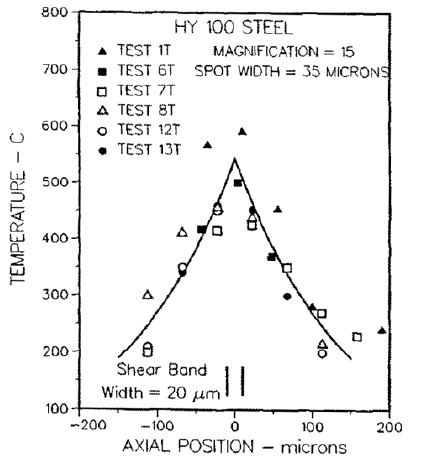
Figure 6. Measured Temperature field in a torsional Kolsky test at a strain rate of 1600 s − 1